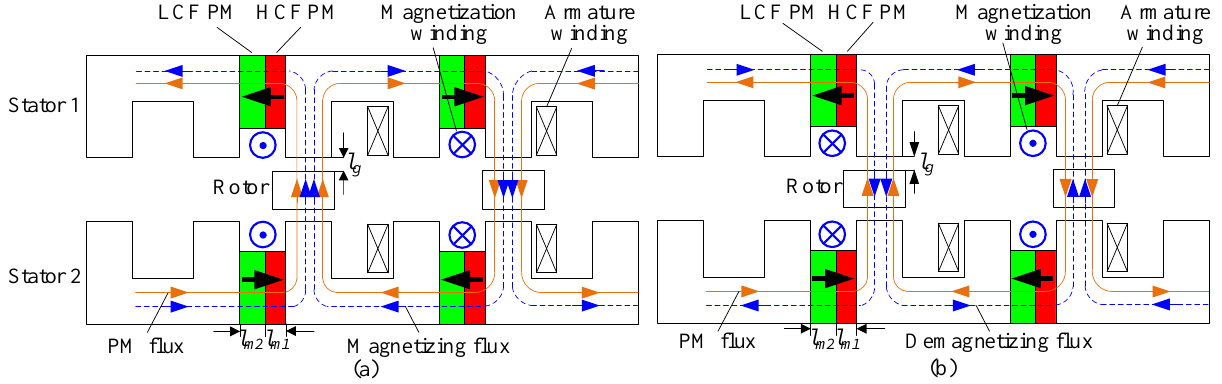
Figure 2. Magnetic flux paths during magnetization: ( a ) magnetizing process; ( b ) demagnetizing process.